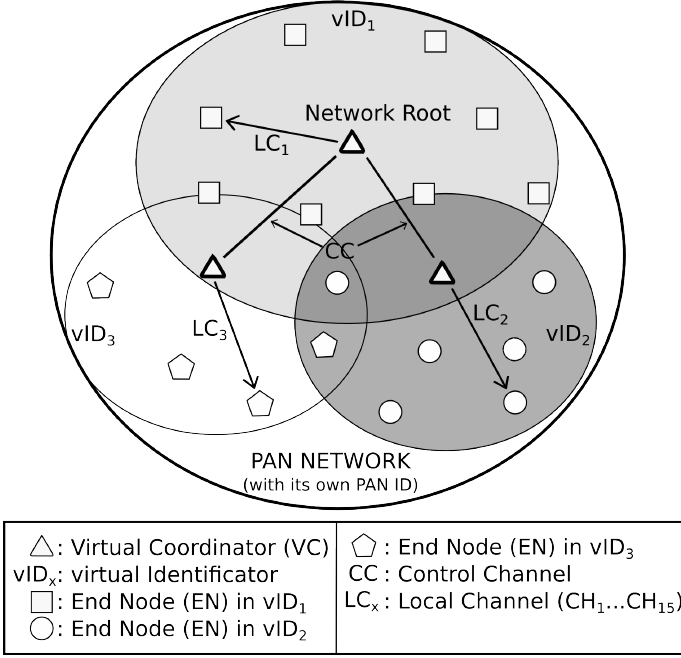
Figure 1. mDARAL basic